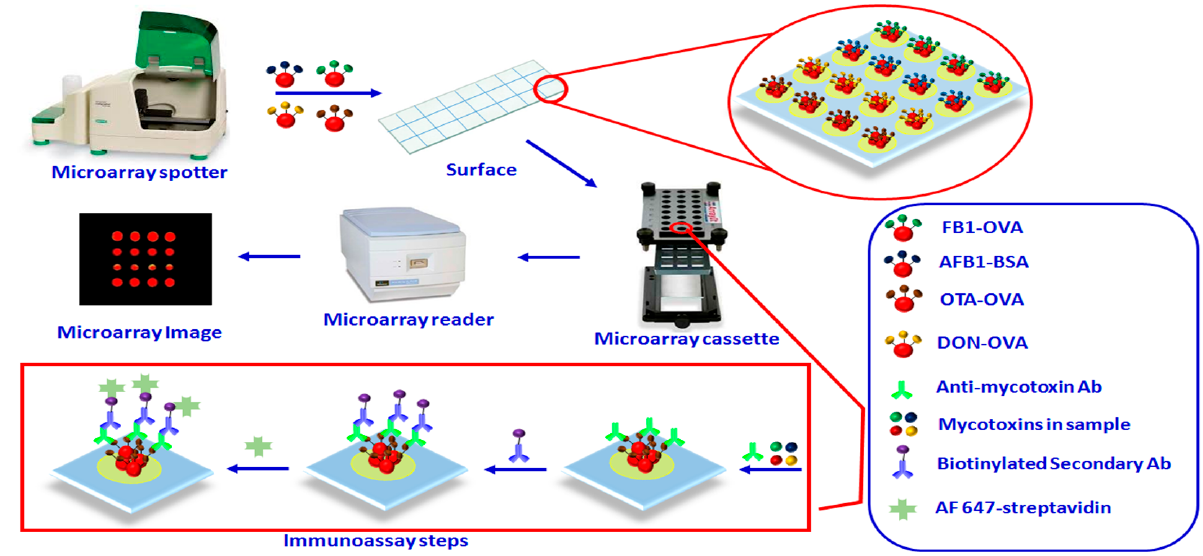
Figure 2. Schematic presentation of the procedures for both microarray fabrication and multiplexed mycotoxin detection with it. The different steps of the assay are also depicted in the lower part of the figure.